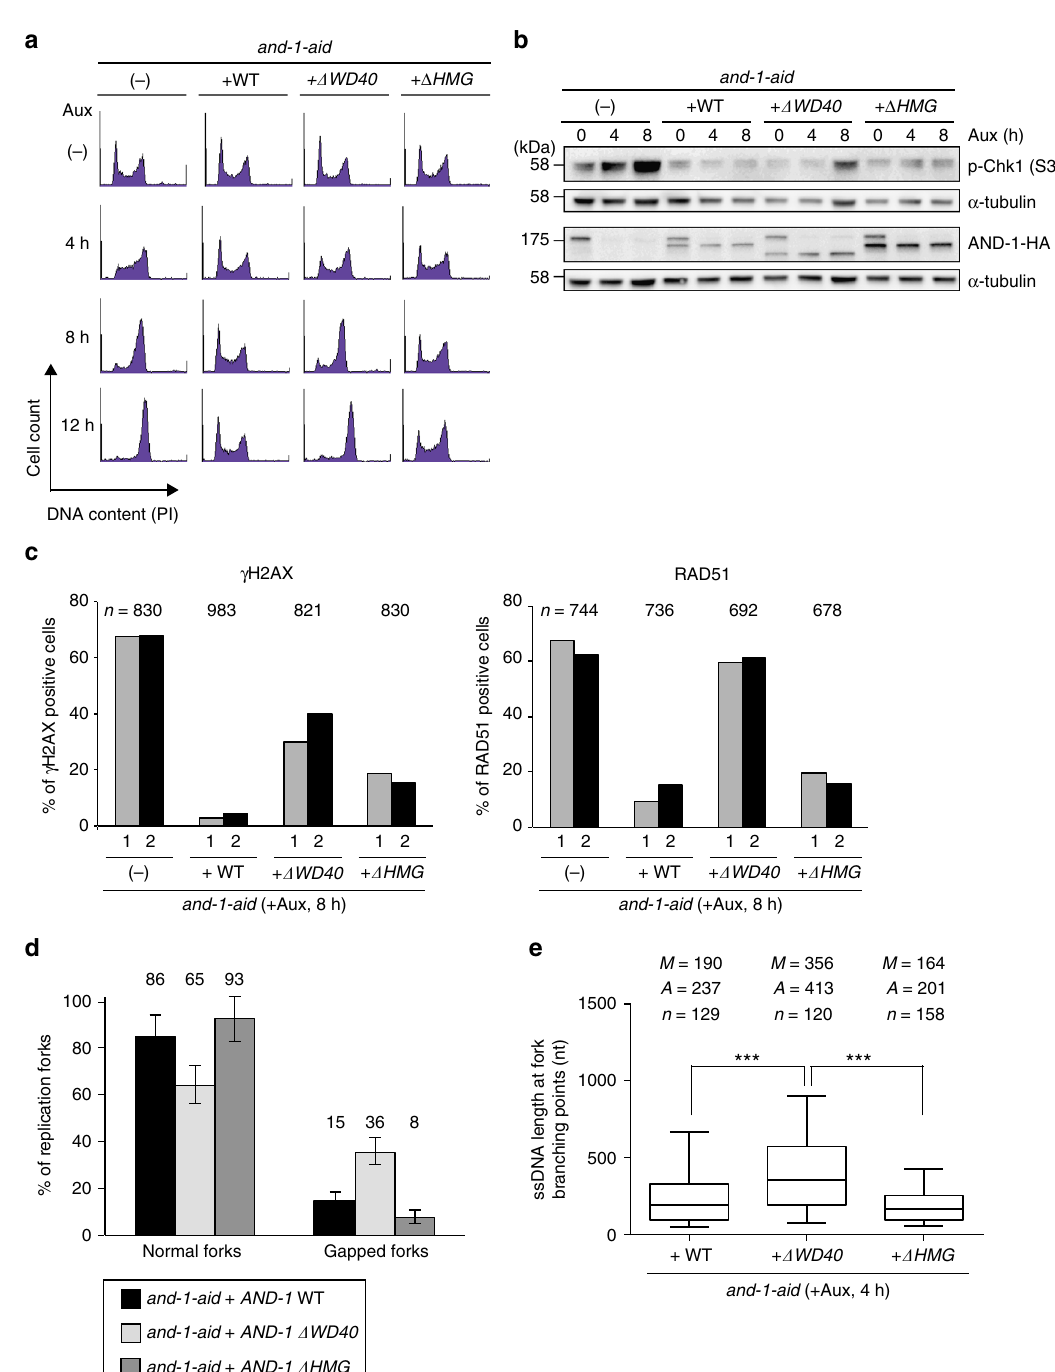
Fig. 6 Identi fi cation of AND-1 domains critical for proliferation and prevention of spontaneous DSB formation. a Cell cycle distribution of AND-1 deletion mutants. Cells of the indicated genotypes were incubated with auxin for indicated times, stained with propidium iodide (PI), and DNA content was analyzed by fl ow cytometry. b Total cell lysates were prepared from cells of the indicated genotypes and analyzed by Western blotting. c Cells of the indicated genotypes were incubated with auxin for 8 h and γ H2AX and RAD51 foci were visualized by immunostaining with speci fi c antibodies. Results of two experiments are shown. n represents the number of cells analyzed in the two experiments. d, e EM analysis of the replication intermediates puri fi ed from the cell lines of the indicated genotype as in Fig. 3d, e. Molecules derive from two independent experiments, for a total number ( n ) of molecules shown in e . n is the total number of replication forks analyzed, A is the average length of ssDNA, and M is the median length of ssDNA. Error bars in d represent SDM obtained from two independent experiments. In the box plots in e , the middle line indicates the median value; the box shows the 25th and 75th percentiles; the bars, the 5th and 95th percentiles. P values were calculated by Student ’ s t -test. *** P ≤